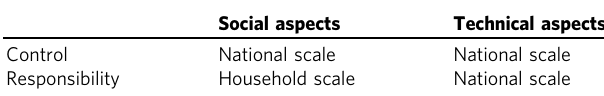
Table 2 Control and responsibility in smart meter rollouts in Norway and